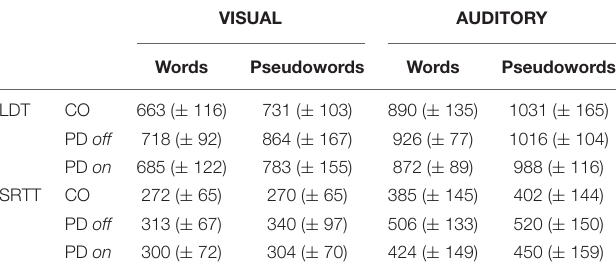
TABLE 2 | Mean reaction times ( ± standard deviation) in ms for word and pseudoword responses, for age-matched controls (CO) and patients with PD on or off medication, in the lexical decision task (LDT) and simple reaction time task (SRTT) in the visual and auditory